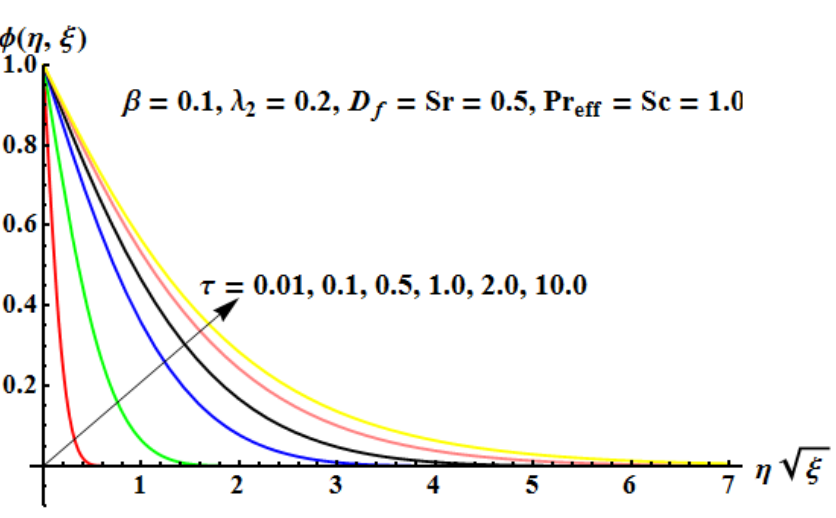
Figure 6. Influence of τ on θ ( η , ξ ) .